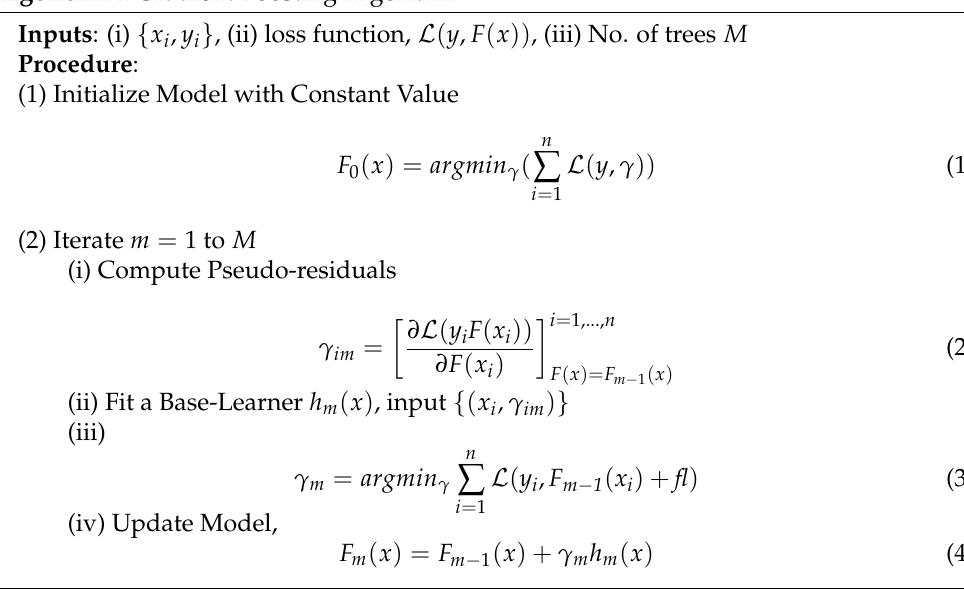
Algorithm 1 Gradient Boosting